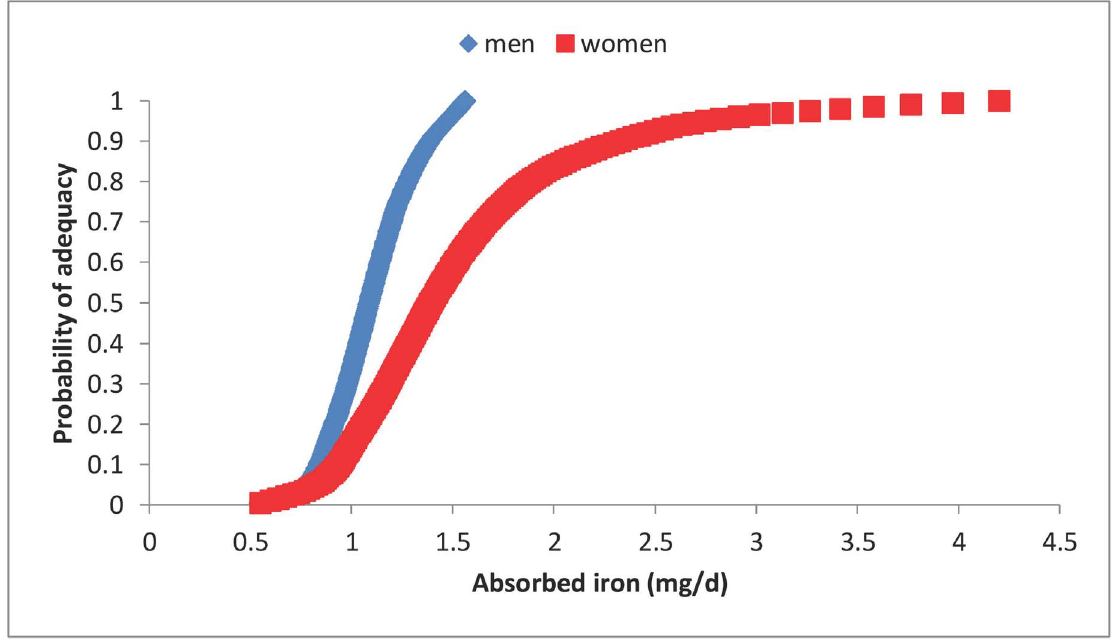
Figure 1. Distribution of estimated iron requirements for men ( ¤ ) and women ( & ): y axis represents the probability of adequacy (0– 1), x axis is absorbed iron (mg/d). This is based on tabulated data from the IOM [11]. The figure shows an interpolation of this data that was estimated using a spline function in R [17].